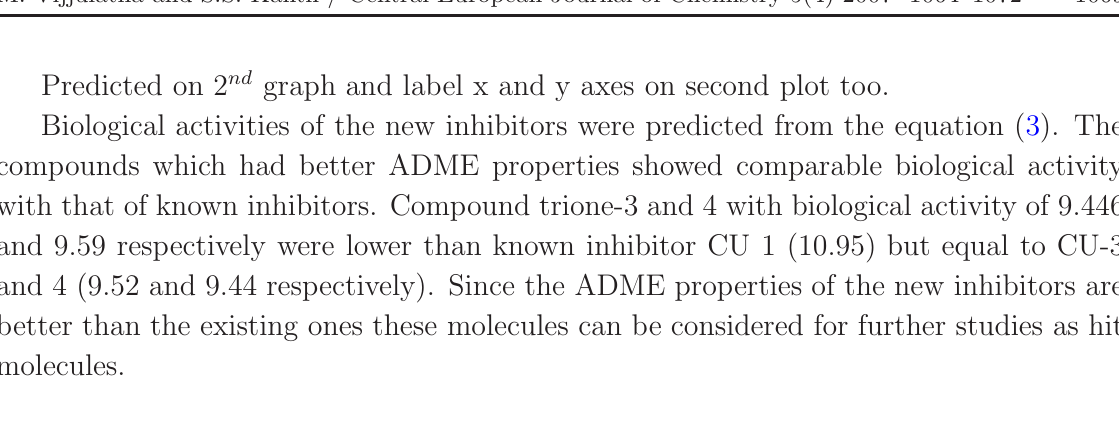
Table 3 Dock Score, complexation energy and protein ligand interaction energy of cyclic urea inhibitors.